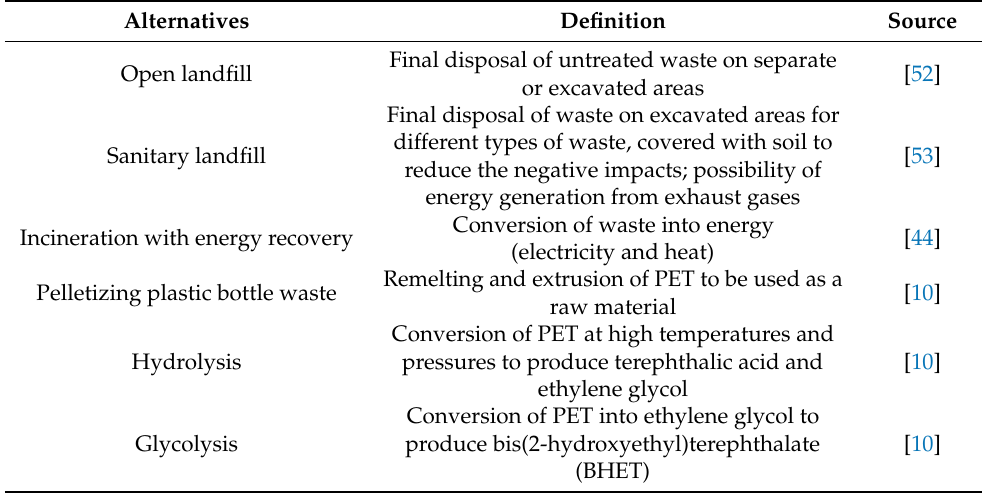
Table 2. Alternatives: processes for the treatment of PET bottle waste. Alternatives